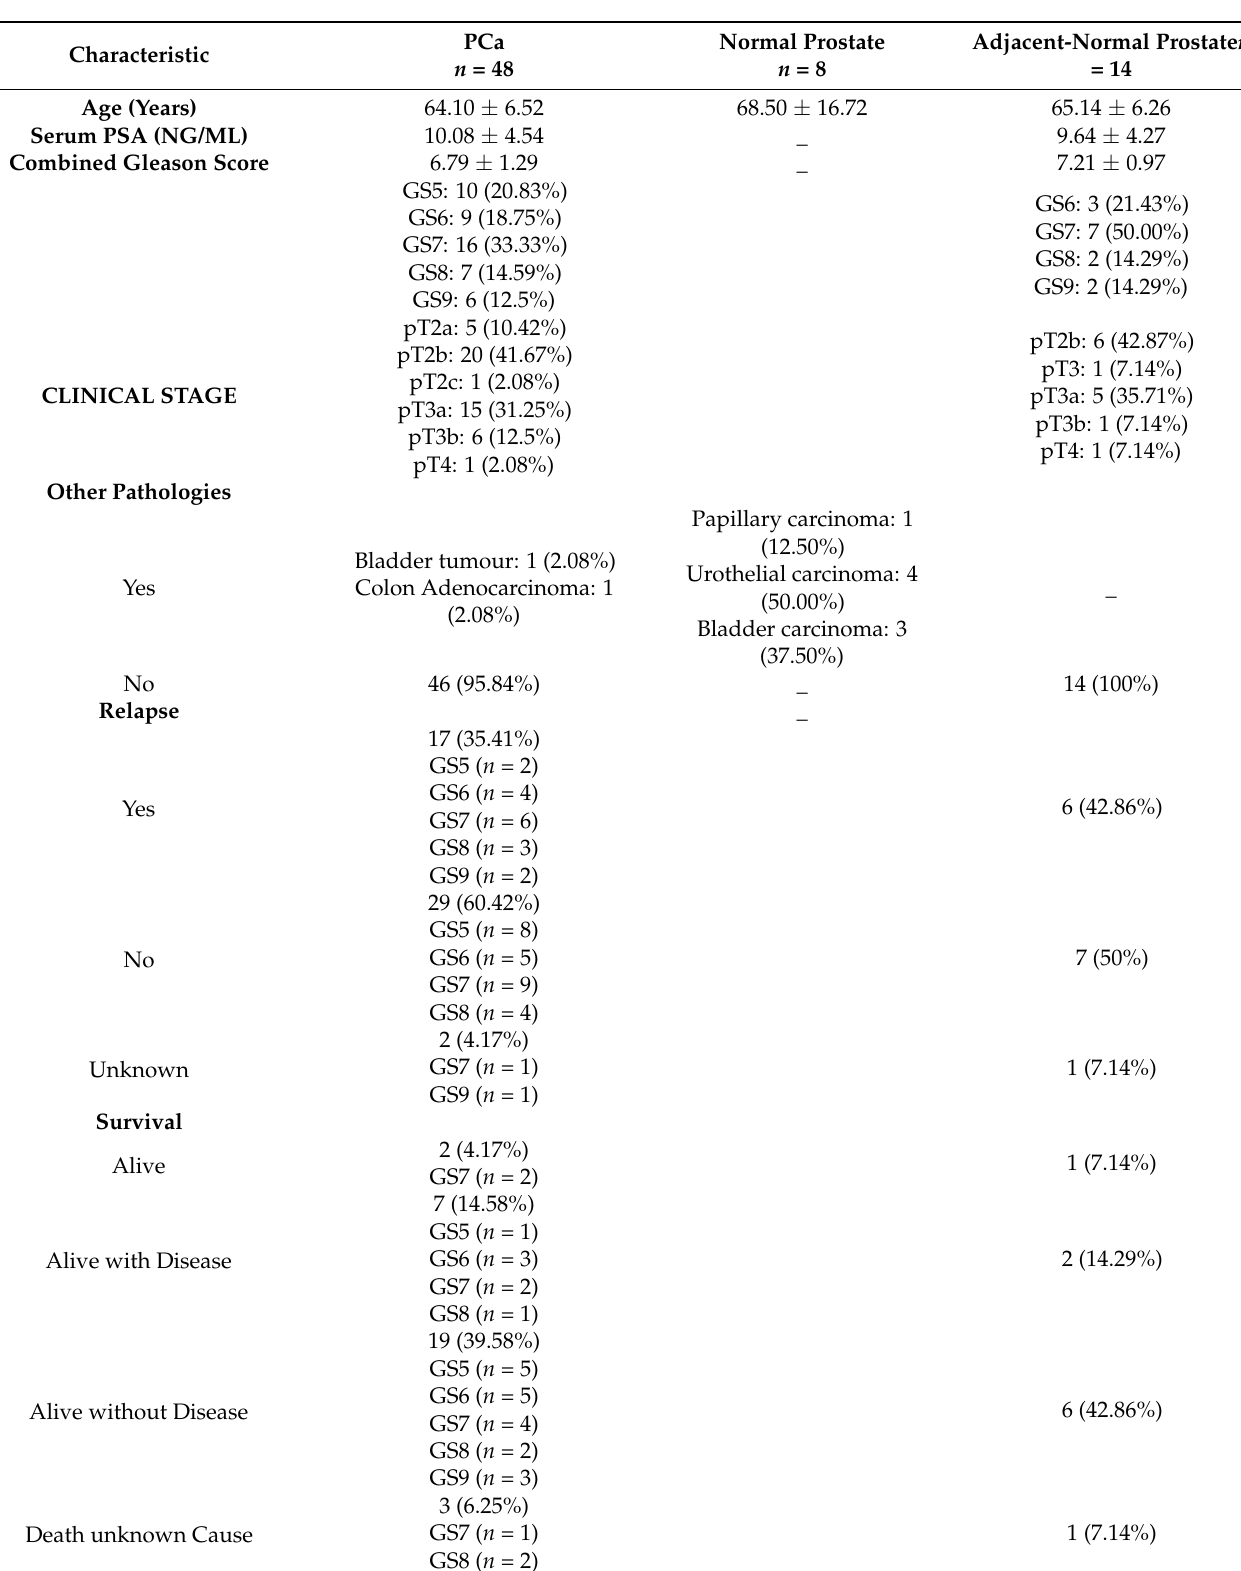
Table 1. Clinical data of the subjects included in the study. PCa Adjacent-Normal Prostate Characteristic